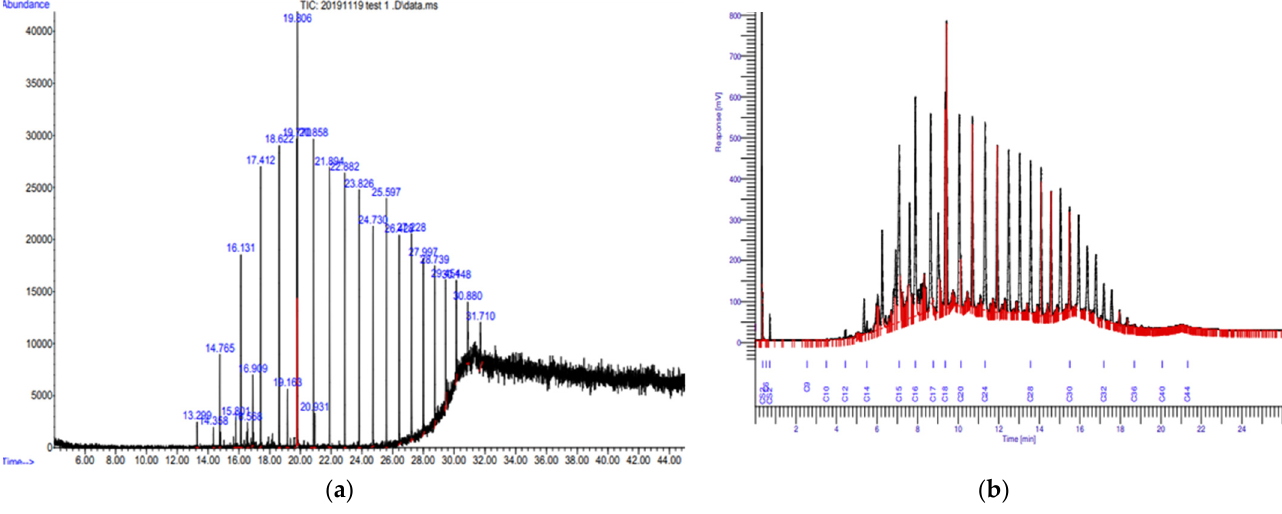
Figure 3. ( a ) GC-MS, and ( b ) GC-FID chromatographs of oily sludge sample.